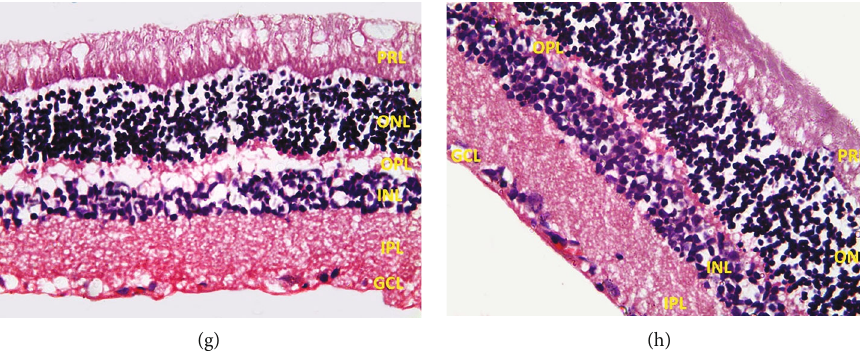
Figure 4: Photograph of the retinas ’ sections stained with H&E. (a) Control group shows normal histological structure of well-organized retinal layers formed by the photoreceptor layer (PRL), outer nuclear layer (ONL), outer plexiform layer (OPL), inner nuclear layer (INL), inner plexiform layer (IPL), and ganglion cell layer (GCL). (b) Diabetic group shows disorganization of retinal layers with near- total disappearance of nuclei of the outer nuclear layer (ONL) (Astrix), disruption of the outer plexiform layer (OPL), and appearance of empty spaces within the inner nuclear layer (INL). Neovascularization in the ganglion cell layer (GCL) with dilated congested blood capillaries (arrow) is also noticed. (c) Diabetic group shows apparent marked reduction of retinal thickness in comparison to the control group and marked disorganization of retinal layers with the appearance of spaces between the nuclei of the outer nuclear layer (ONL) and many spaces in the inner nuclear layer (INL). Multiple cavities within the photoreceptor layer (PRL) are also detected. Retinal folding with disruption of the outer plexiform layer is seen (arrowheads). Dilated congested blood vessels (arrows) and a reduction in the counts of ganglion cells within the ganglion cell layer (GCL) can be detected (retina). (d) Diabetic group shows neovascularization within the ganglion cell layer (GCL). (e) Diabetic group shows an increased number of supporting cells with dark nuclei within the ganglion cell layer. (f, g) Melatonin and stem cell groups, respectively, show well-organized retinal layers but with appearance of many small empty spaces in PRL, ONL, and INL. Neovascularization is still found in GCL. (h) Melatonin+stem cell group: the total retinal thickness is apparently preserved, the inner nuclear layer (INL) appears with higher cell density, the inner plexiform layer (IPL) preserves its reticular appearance with no widening of the spaces between its fi bers, and (d) the ganglion cell layer (GCL) is formed by one row of ganglion cells (GC). H&E, ×